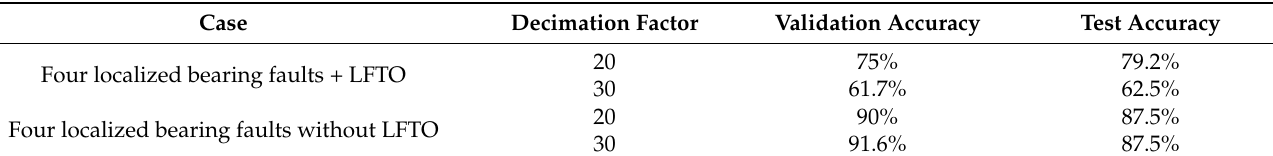
Table 7. Validation and test accuracy for the two classifications with four classes each (spectrogram images).